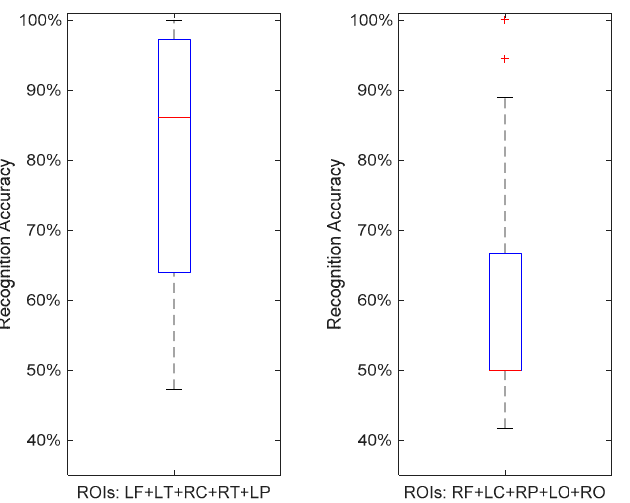
Figure 5. Boxplots for LOO approach using SVM. ( Left ): hyper-COH group, mean accuracy 81.64%; ( Right) : hypo-COH group, mean accuracy 61.33%. Red lines indicate the median accuracies.